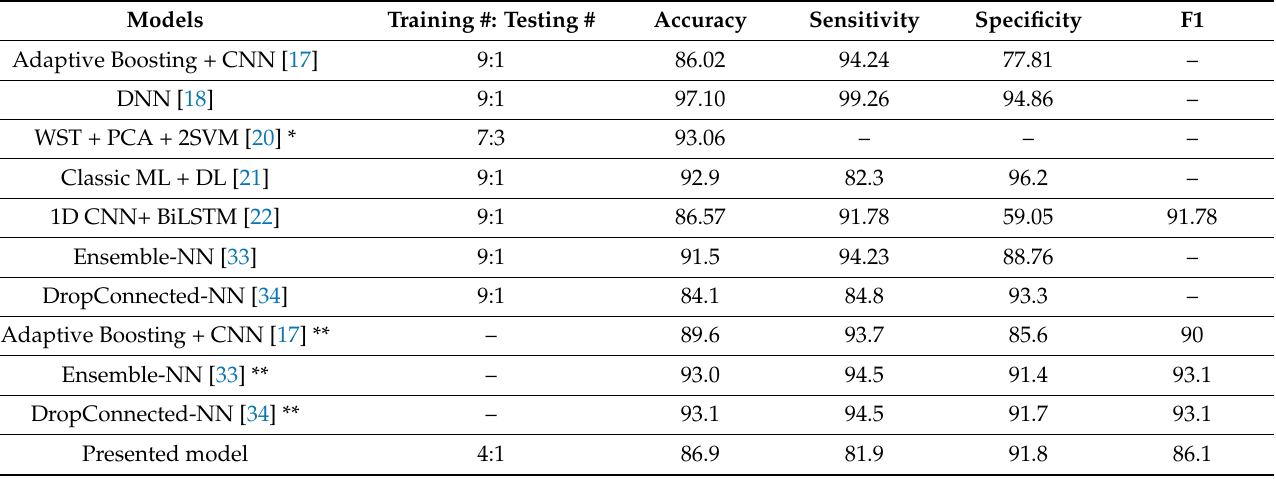
Table 5. Comparison